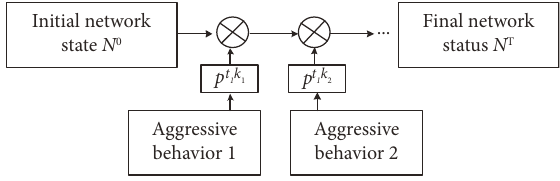
Figure 3: The network attack model framework.